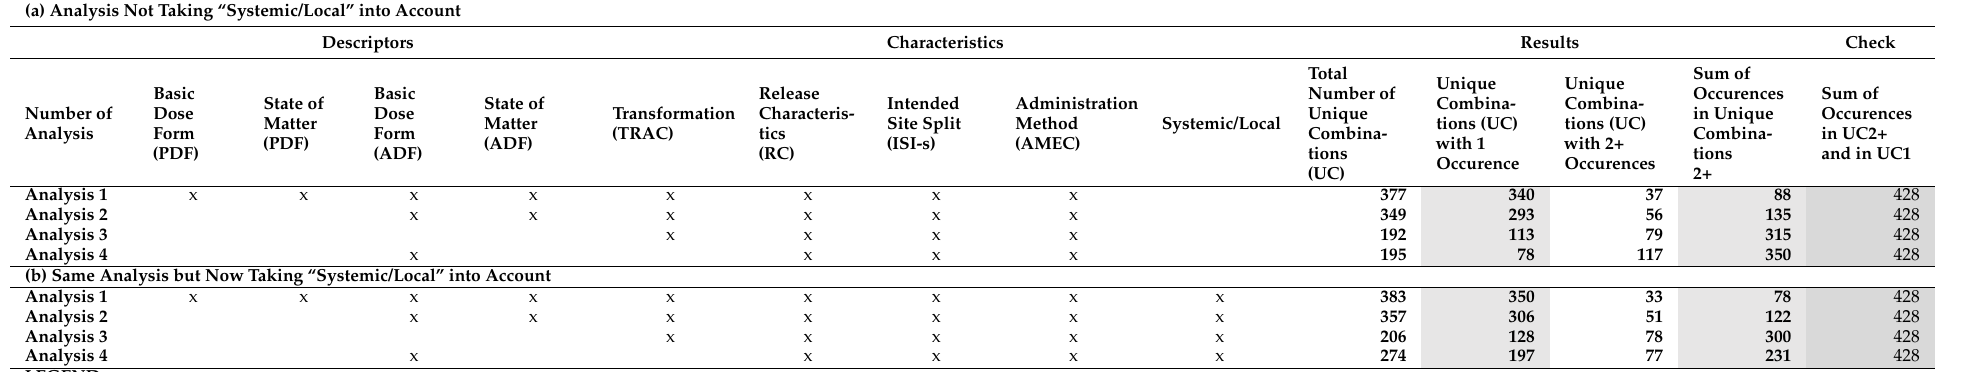
Table 1. Analysis of unique combinations in different sets of descriptors and characteristics of EDQM dose